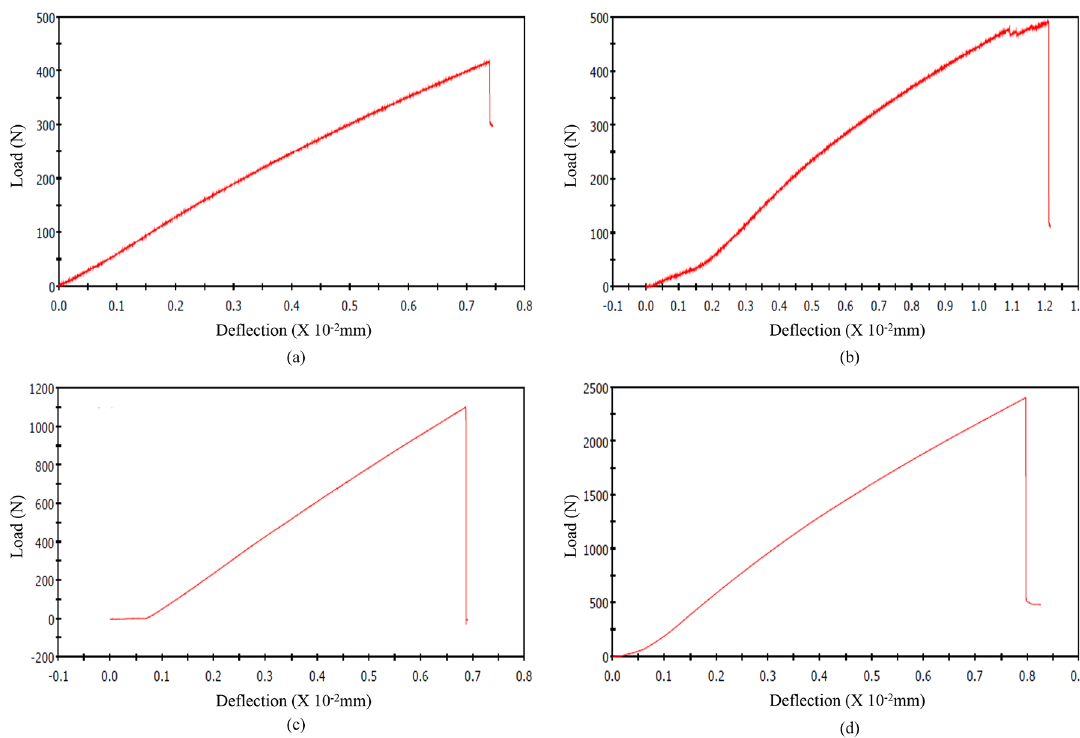
Figure 3. Load (N) versus deformation (mm) curves, for malva/epoxy composites with different amounts of malva fibers: (a) 0%; (b) 10%; (c) 20% and (d) 30% in